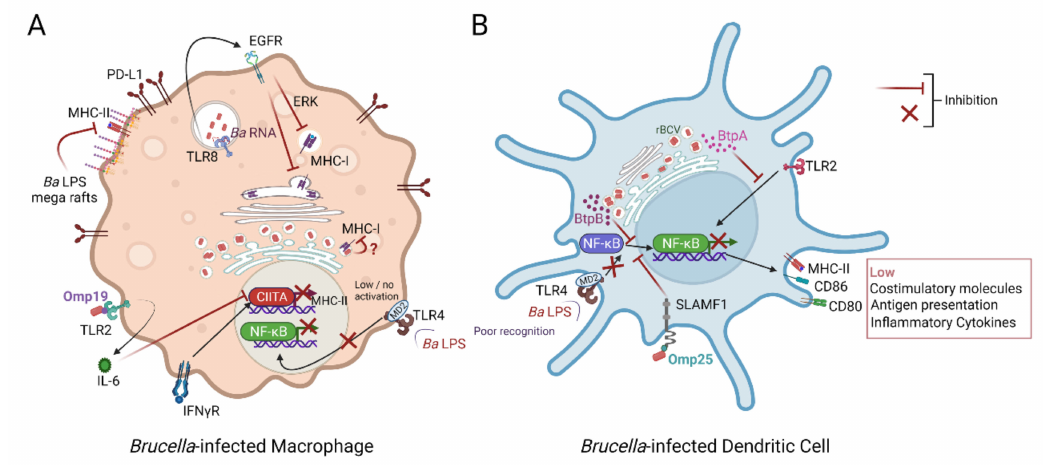
Figure 1. Mechanisms of Brucella’s antigen presentation impairment . Brucella has evolved multi- ple ways to dampen antigen presentation by ( A ) macrophages and ( B ) dendritic cells, preventing proficient development of an adaptive immunity. ( A ) Recognition of Brucella lipoproteins by TLR2 leads to IL-6-dependent inhibition of the transcription factor CIITA, resulting in diminished transcrip- tion and expression of IFN- γ -induced MHC-II. Moreover, Brucella abortus LPS ( Ba LPS) reaches the cell surface, forming macrodomains with MHC-II molecules and interfering with the presentation of peptides to CD4 + T cells. This impairment also influences cytotoxic CD8 + T cells, since recognition of Brucella abortus RNA ( Ba RNA) induces retention of MHCI molecules within the Golgi apparatus via TLR8 and the EGFR pathway. ( B ) The Omp25-SLAMF1 interaction limits NF- κ B translocation to the nucleus, decreasing pro-inflammatory cytokine secretion and costimulatory molecules expression in dendritic cells. The Brucella effectors BtpA and BtpB, translocated to the cytoplasm during infection, interfere with TLR2 and TLR4 signalling and control dendritic cell maturation. In both cell types, the peculiar structure of the Ba LPS, specially its core, makes it poorly recognised by the TLR4-MD2 complex preventing full activation, NF- κ B translocation and impairing dendritic cell maturation and T cell activation. Nuclear phosphorylated active NF- κ B dimers are represented in